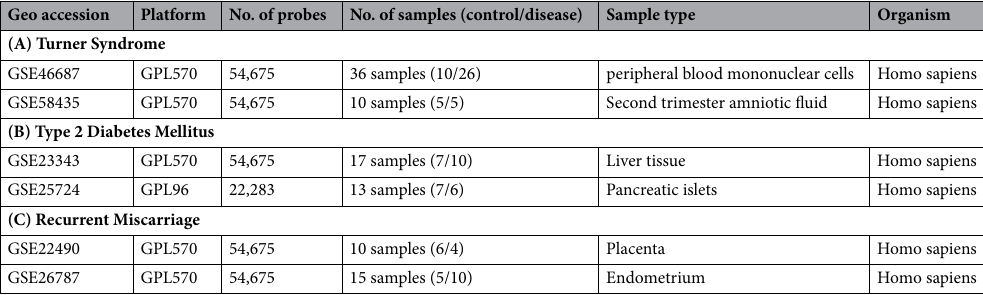
Geo accession Platform No. of probes No. of samples (control/disease) Sample type